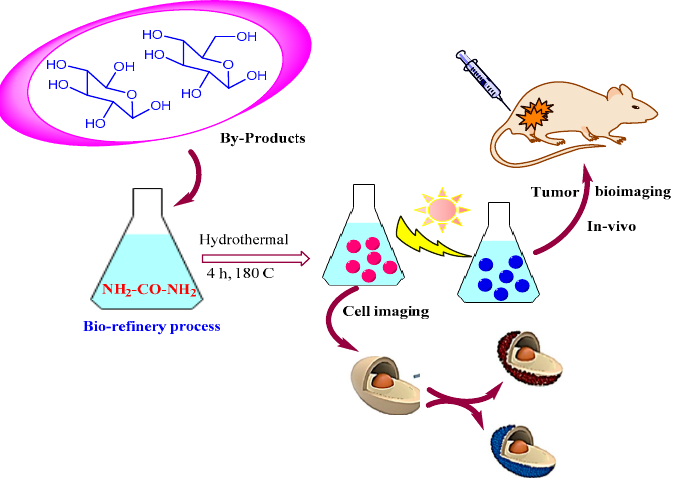
Figure 5. Eco-friendly fabrication of CQDs from some of the biorefinery by-products.